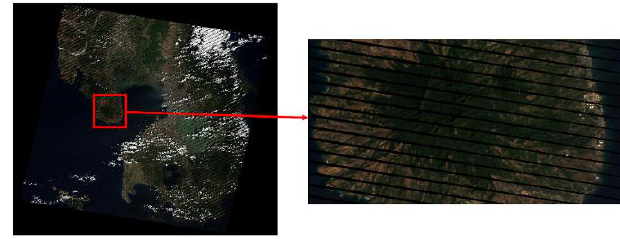
Figure 5 . Scan Line Error (SLC)